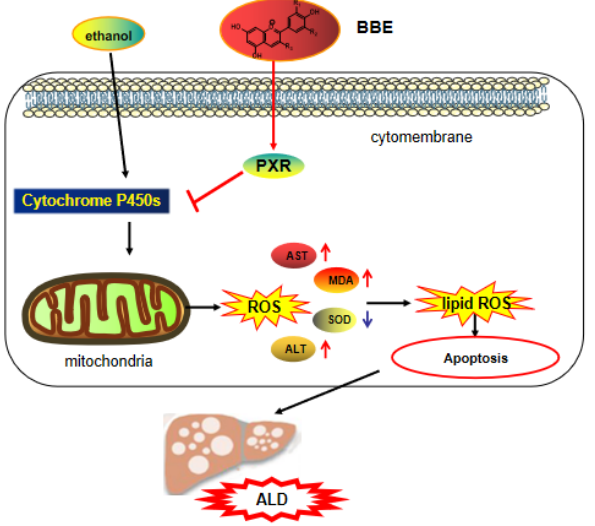
Figure 9. The mechanism of BBE regulating of activating the PXR-Cytochrome P450s